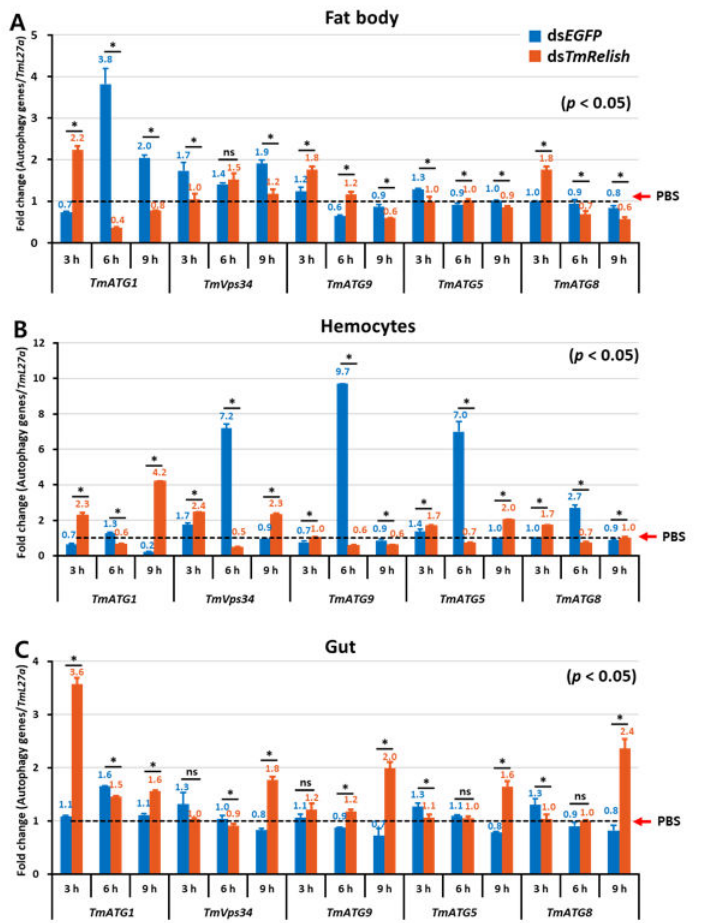
Figure 4. E ff ect of TmRelish gene silencing on the expression level of T. molitor autophagy-related genes ( Tm ATG) in the fat body ( A ), hemocytes ( B ), and gut ( C ) of larvae at 3, 6, and 9 h after L. monocytogenes challenge. Transcriptional levels of TmATG1 , TmVps34 , TmATG9 , TmATG5 , and TmATG8 were quantified by qRT-PCR. All experiments were performed on three independent sets. asterisks ‘*’ indicate statistically significant di ff erences between the ds TmRelish - and ds EGFP -treated groups using Student’s t-tests ( p < 0.05) and ns = not